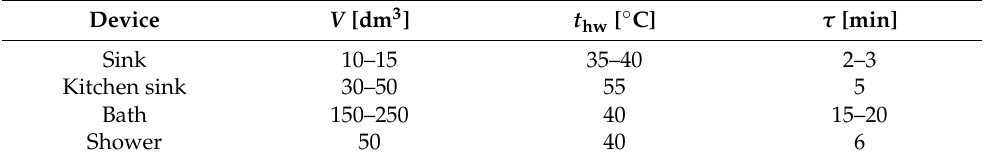
Table 1. Typical values of volume flowing from the water device, temperature of water and time of use for calculating the peak power for hot water preparation using Sander’s